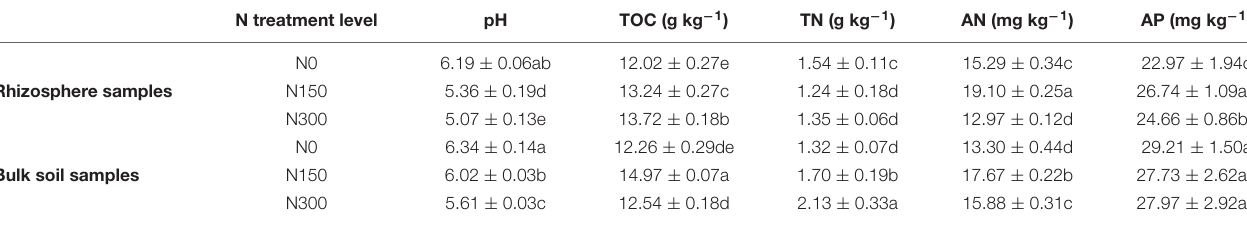
TABLE 2 | Soil pH and carbon (C)-, nitrogen (N)-, and phosphorus (P)-nutrient contents of rhizosphere and bulk soil samples subjected to the three nitrogen (N) fertilization levels.